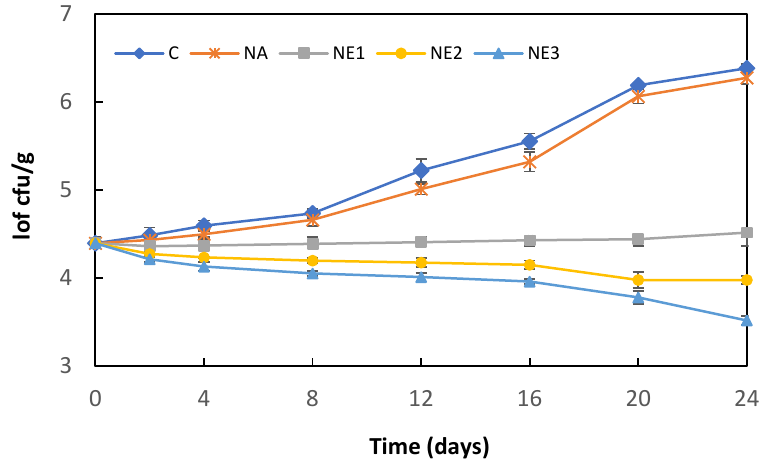
Figure 3. Changes in L. monocytogenes counts of cheese samples during storage. C: Control, uncoated cheese; NA: samples coated ultrasound-treated sodium alginate solution without the incorporation of myrtle essential oil; NE 1 , NE 2 , NE 3 : samples coated ultrasound-treated sodium alginate solution with the incorporation of 0.5, 1.0, or 2.0% myrtle essential oil, respectively. Error bars represent standard deviation.